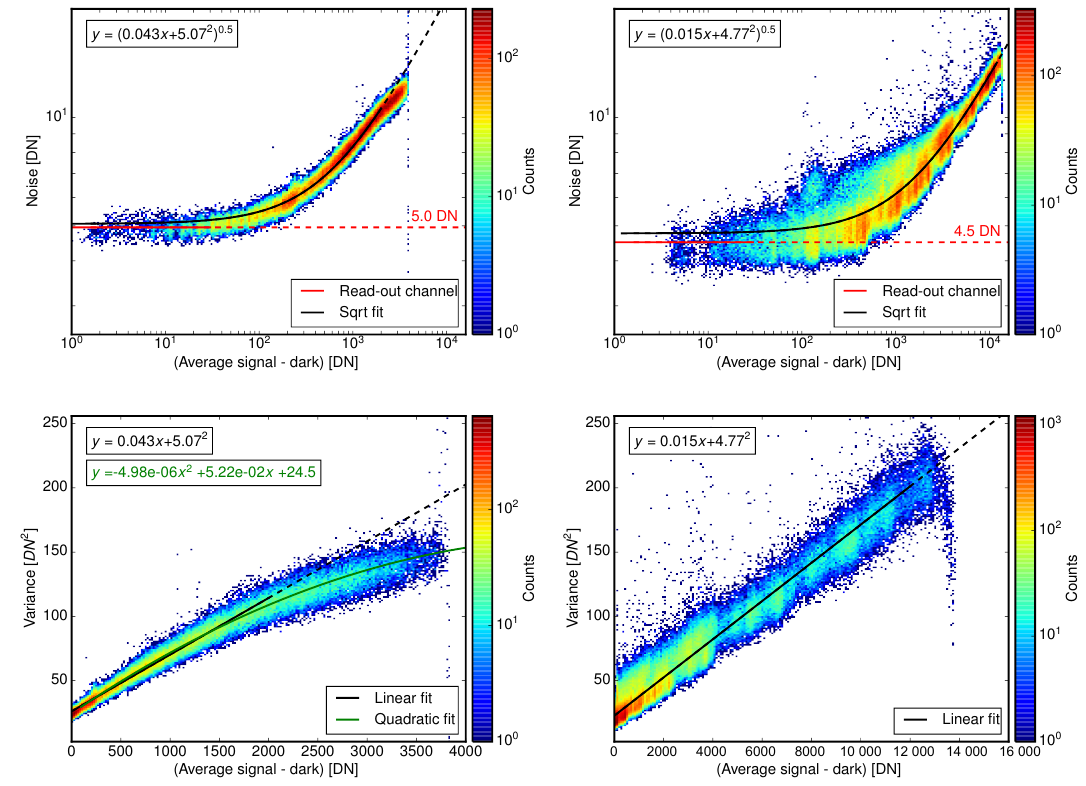
Figure 13. Noise characteristics for the (left) VNIR and (right) SWIR spectrometer. Top: the noise σ N (standard deviation of S ) is shown against the mean, dark-current-corrected signal level (cid:104) S 0 (cid:105) . Bottom: noise variance σ 2